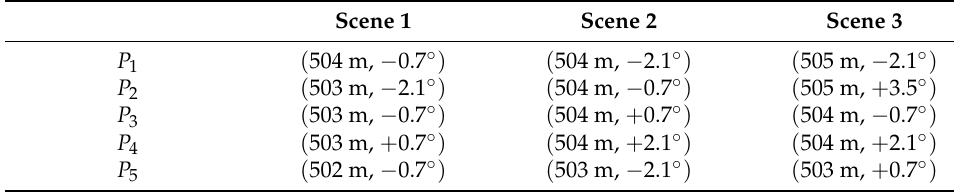
Table 3. Partial scattering point coordinates ( r , α ) of different imaging scenes.